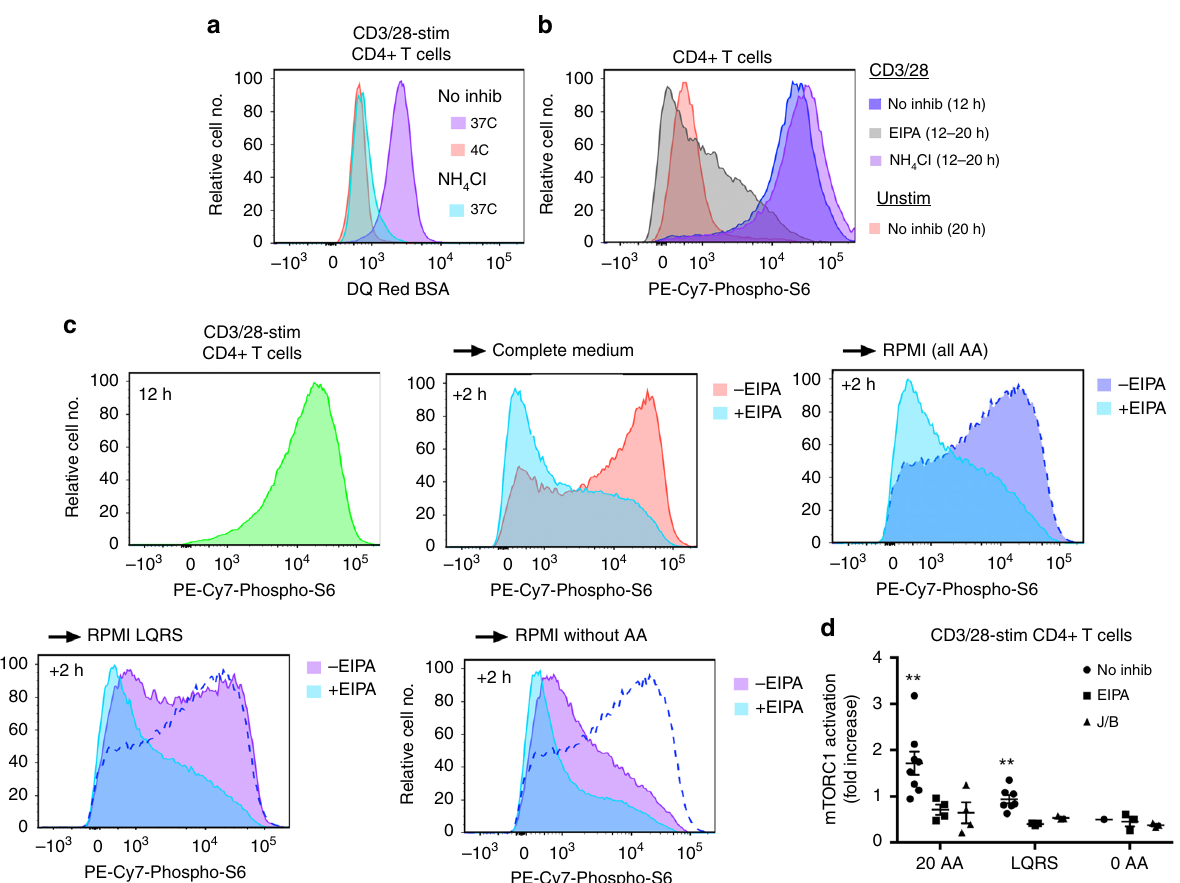
Fig. 5 Macropinocytosis delivers free AA to T cells necessary for sustained activation of mTORC1. a , b Splenocytes were stimulated with CD3/28 mAb for 12 h followed by incubation with DQ Red BSA for 4 h at the indicated temperatures in the presence or absence of NH 4 Cl ( a ) or for 8 h at 37 °C in the presence or absence of EIPA or NH 4 Cl ( b ). Flow cytometry histogram plots show DQ Red BSA fl uorescence ( a ) or phospho-S6 levels ( b ) in CD4 + T cells. Plots are representative of three repeat experiments (see Supplementary Fig. 6b, d). c Splenocytes were stimulated with CD3/28 mAb in complete medium (RPMI plus FCS) for 12 h, washed and recultured in the indicated media for 2 h in the presence or absence of EIPA. Representative fl ow cytometry histograms show phospho-S6 levels in CD4 + T cells. All panels are from the same experiment. The mid-blue-dashed line indicates all AA in the absence of EIPA. d Mean±1 SEM of the fold increase in mTORC1 activation in CD4 + T cells at 14 h relative to the 0 AA control in the absence of inhibitors ( n = 8 and 7 independent experiments for 20 AA and LQRS, respectively, in the absence of inhibitors; n = 4 for 20 AA and n = 3 independent experiments for LQRS and 0 AA in the presence of inhibitors). ** P < 0.01 by Student ’ s 1-sample 2-sided t -test. Source data are provided as Source Data fi